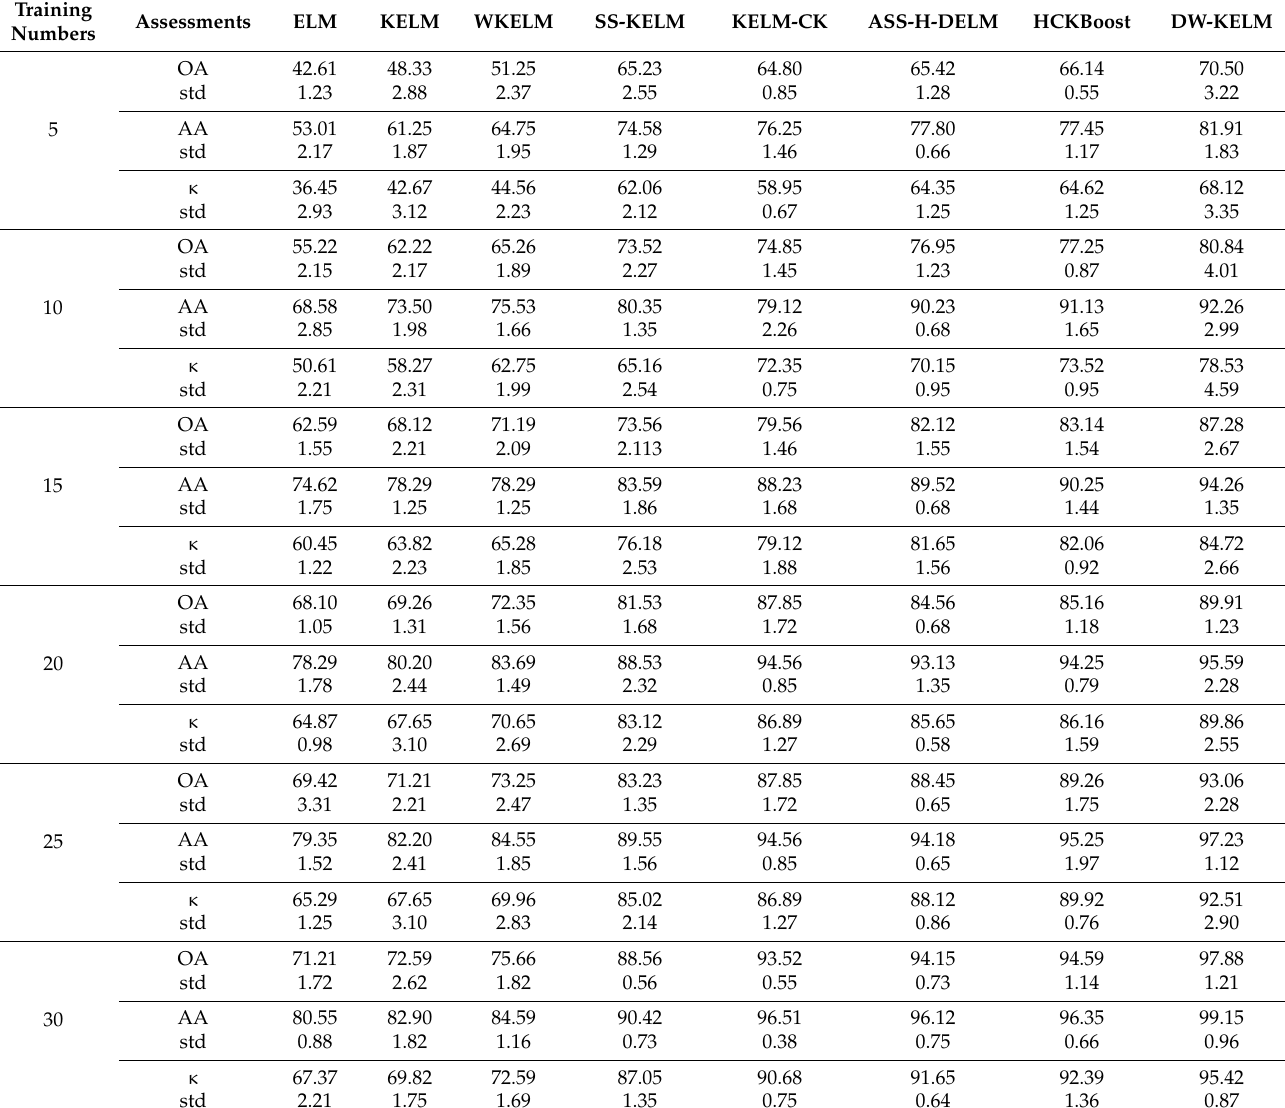
Table 2. OA, AA, and kappa (%) obtained with different training numbers of labeled samples per class on the Indian Pines data set. Training